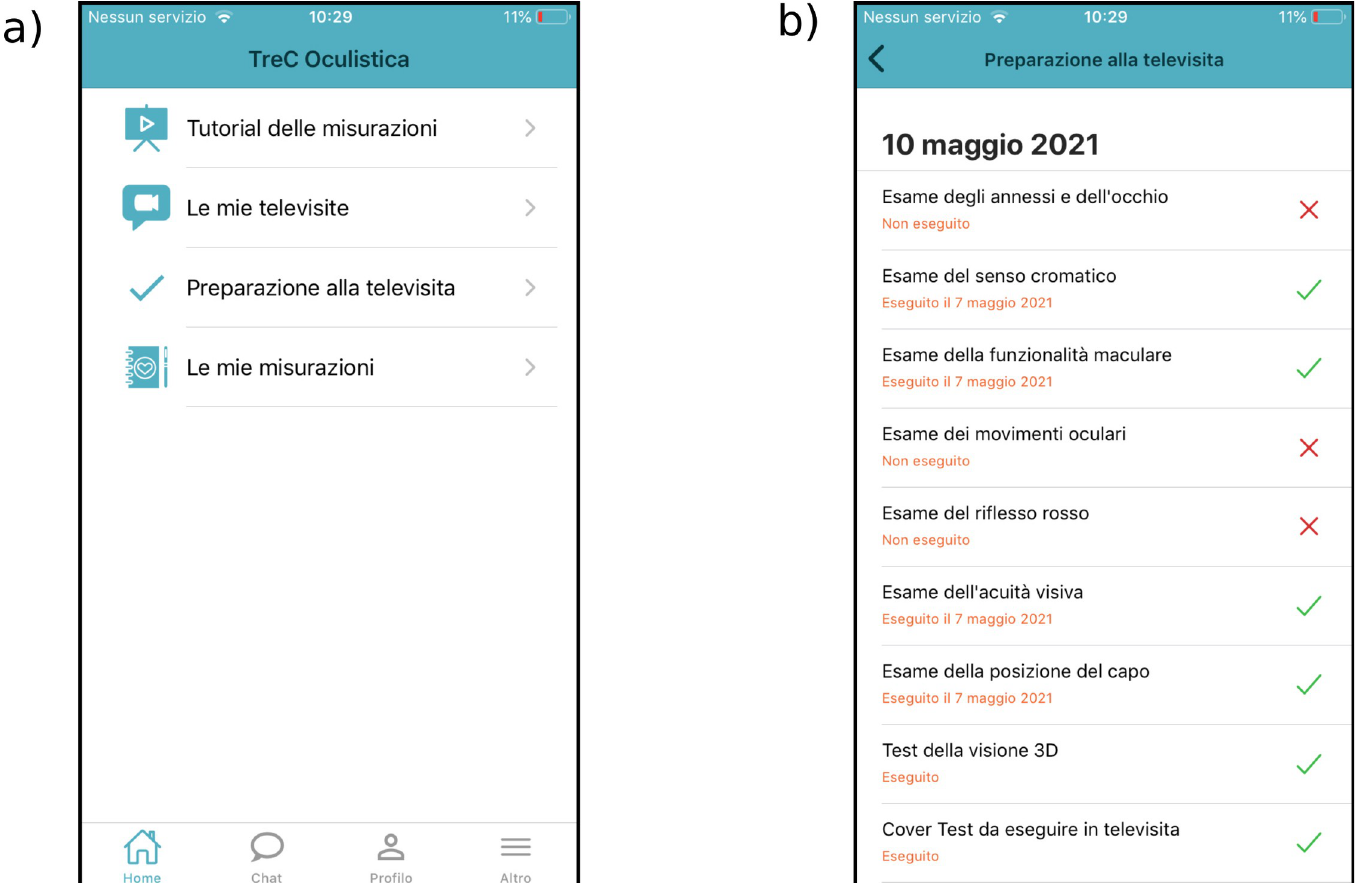
Fig 2. Examples of Patient’s App screens. A: Patient’s App Home screen: The main functionalities embedded in the platform are listed in the Home screen of patients’ mobile application. B: Televisit preparation screen: each required measurement is listed in the Televisit’s preparation screen. A red cross beside the measurement name indicates a non-completed task, a green tick indicates a completed